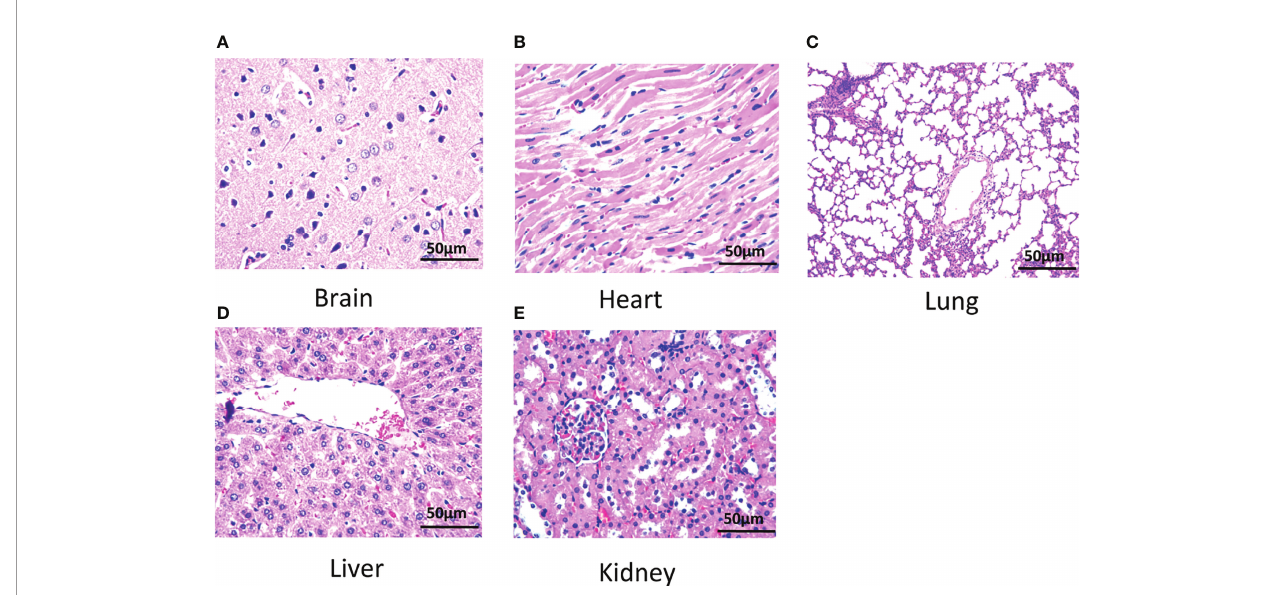
FIGURE 8 | Histology of tissues of rats. (A) Brain, (B) heart, (C) lung, (D) liver, and (E) kidney. N = 6. The dose of BPA was 125 mg/kg body weight. The age of male rats was 8 weeks. Blood and tissues were collected at 3 h after BPA injection for safety evaluation.